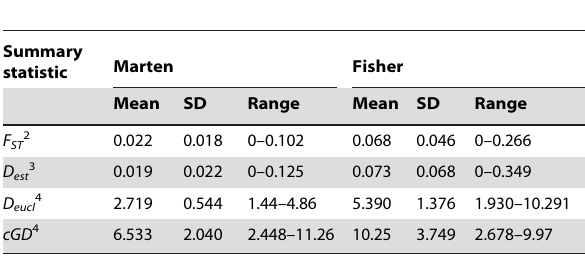
Table 1. Summary of genetic datasets 1 used in a study of genetic connectivity measures.